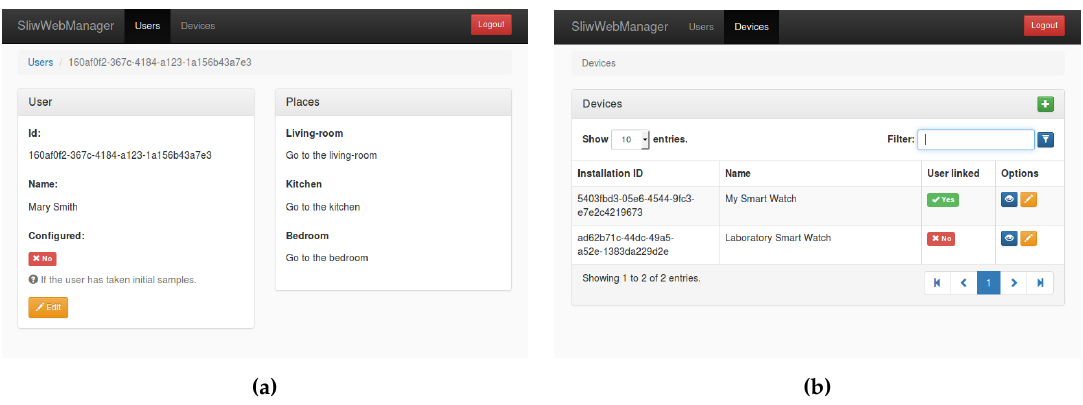
Figure 4. Devices management. ( a ) A name is given to the new device registered; ( b ) List of all devices